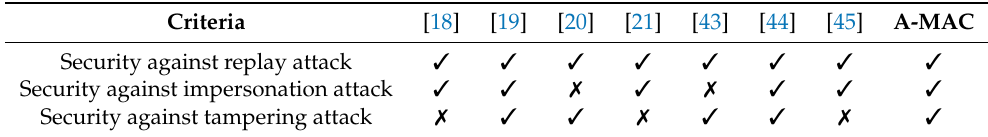
Table 4. Summary of performance of various schemes under